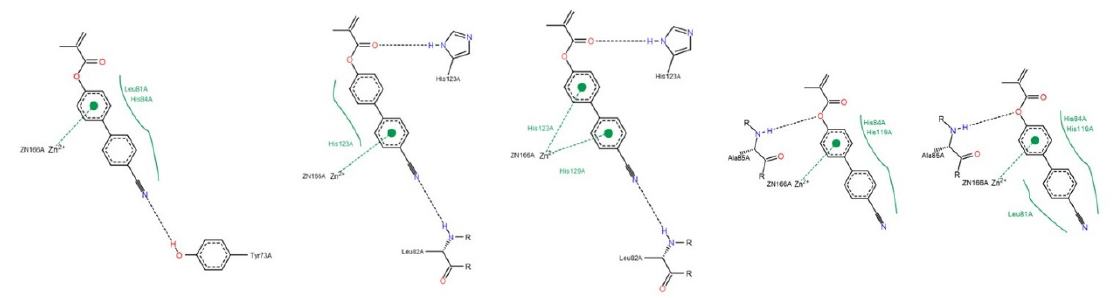
Figure A9. Interactions between compound A and MMP-9, by PoseView calculations.